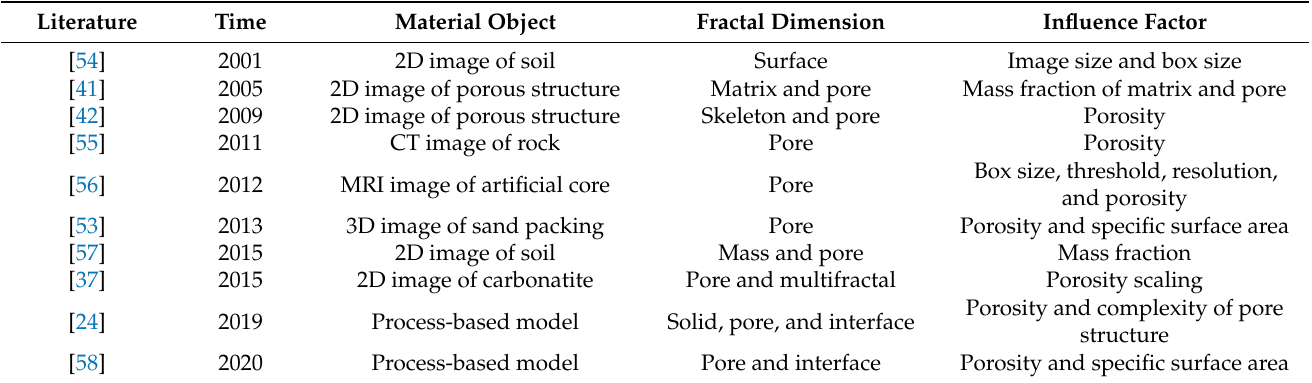
Table 1. Research progress on the relationship between box-counting fractal dimension and pore parameters of porous